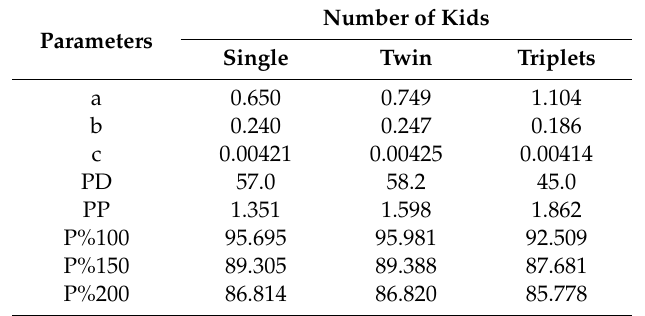
Figure 3. Linearized Wood’s function lactation curves across the number of kids levels.